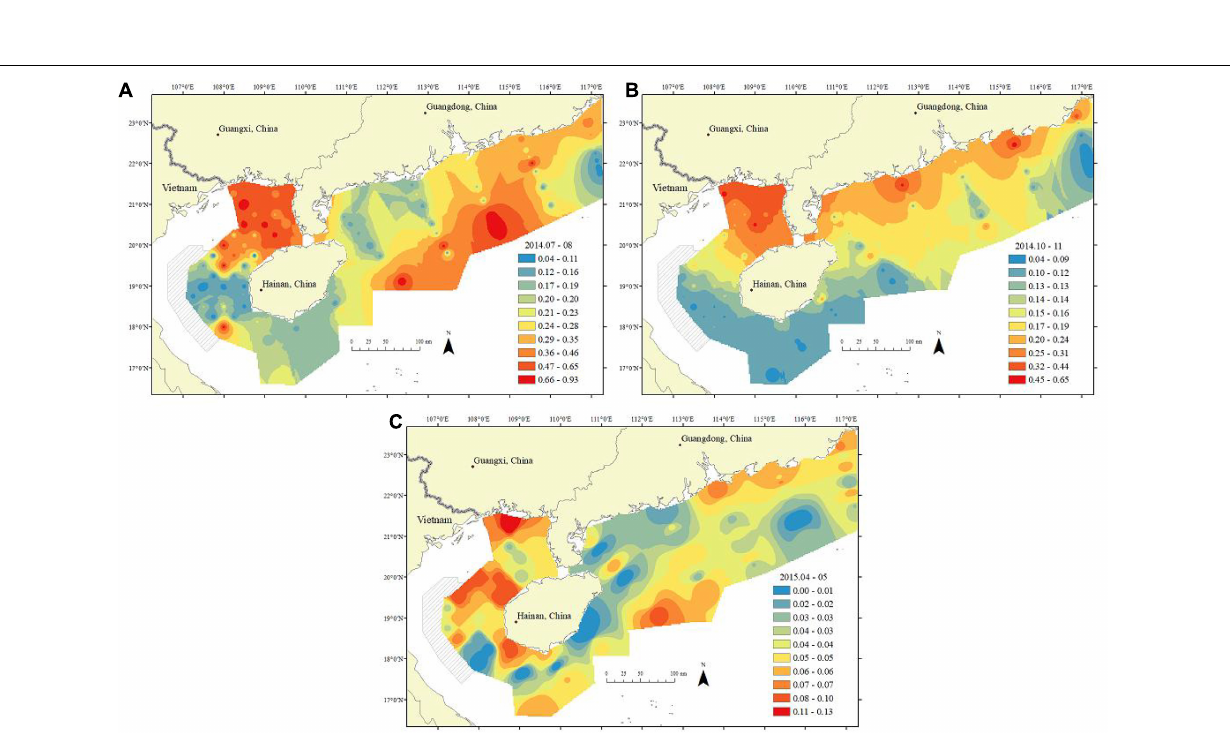
Frontiers in Marine Science |